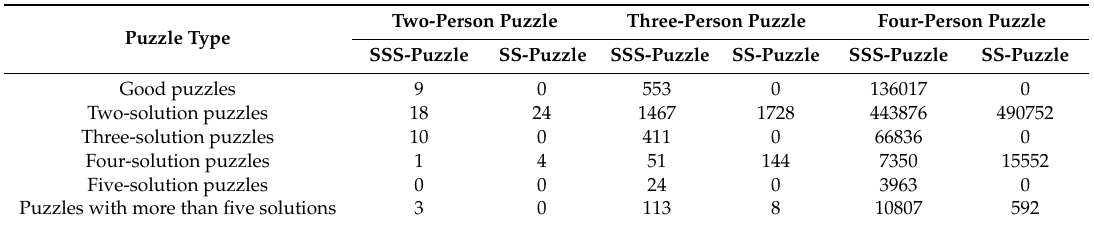
Table 4. The number of SS- and SSS-puzzles with one, two, three, four, five, or more solutions for puzzles with two, three or four persons.